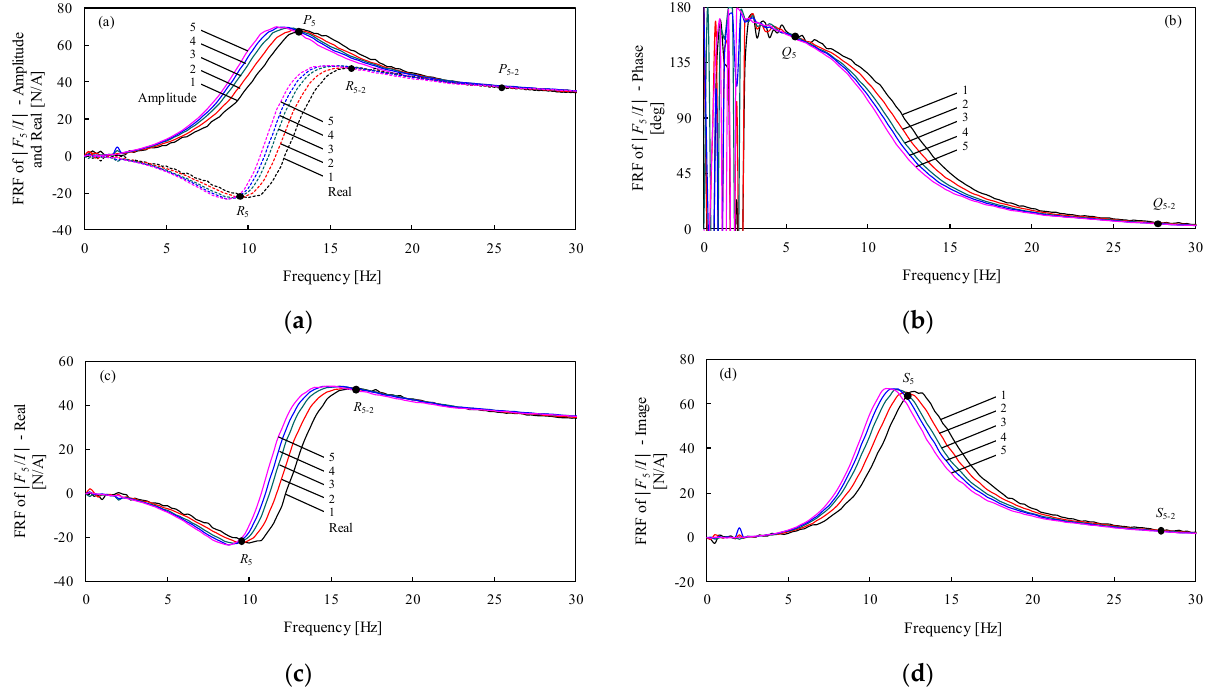
Figure 7. Experimental validation for the active dynamic properties in mid-low-frequency bands and the paired fixed points P 5 – P 5-2 , Q 5 – Q 5-2 , R 5 – R 5-2 , and S 5 – S 5-2 of an AHM-IT-DM-OCA in fluid-filled state. ( a ) Amplitude and real part of the FRFs; ( b ) phase of the FRFs; ( c ) real part of the FRFs; ( d ) imaginary part of the FRFs. Key : The numbers 1–5 correspond to excitation current amplitudes of I = 1, 3, 5, 7 and 9 A, respectively.